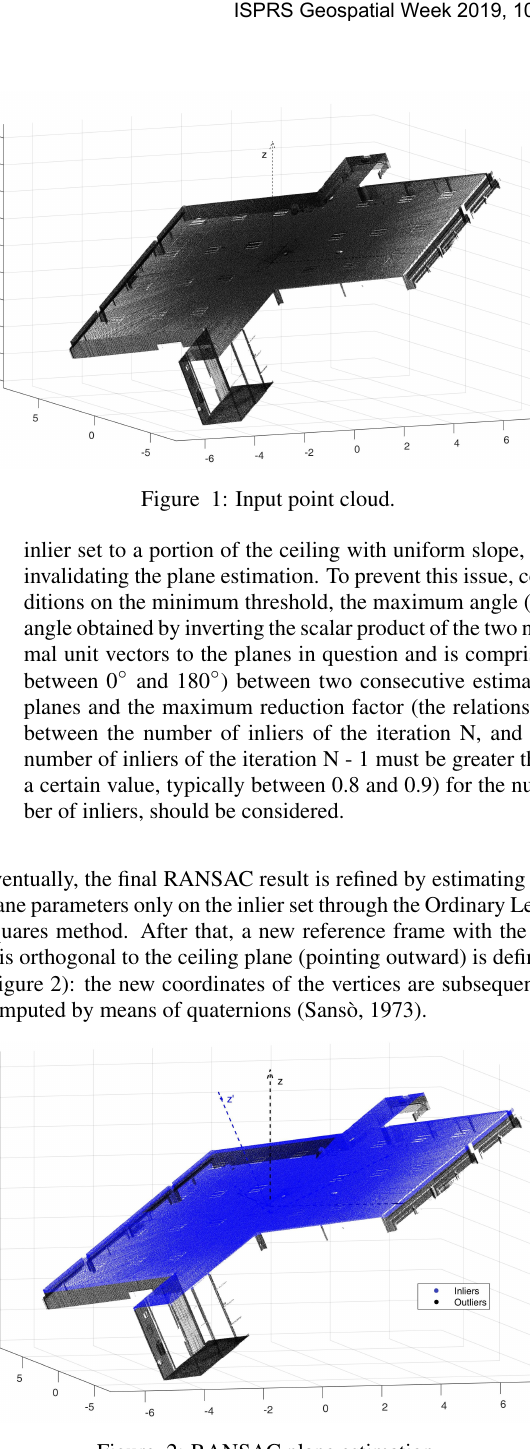
Figure 2: RANSAC plane